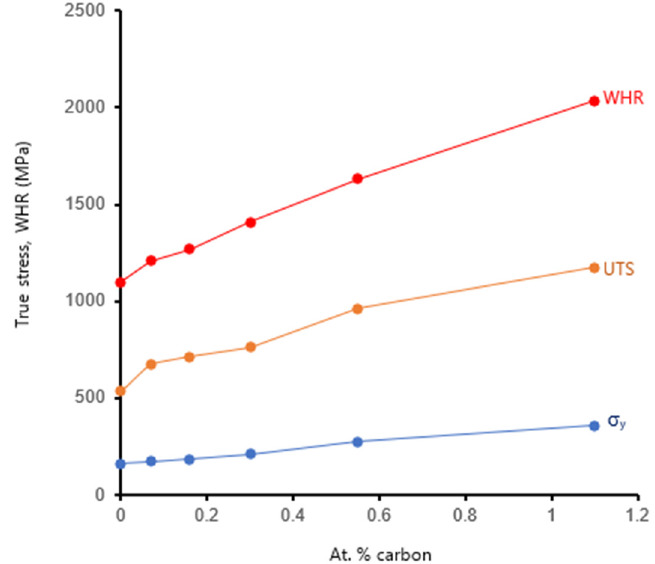
Figure 5. Yield stress ( σ y ), ultimate tensile strength (UTS) and work-hardening rate (WHR) as a function of atomic percent carbon in Fe 40.4 Ni 11.3 Mn 34.8 Al 7.5 Cr 6 . Data from Wang et al. [39].